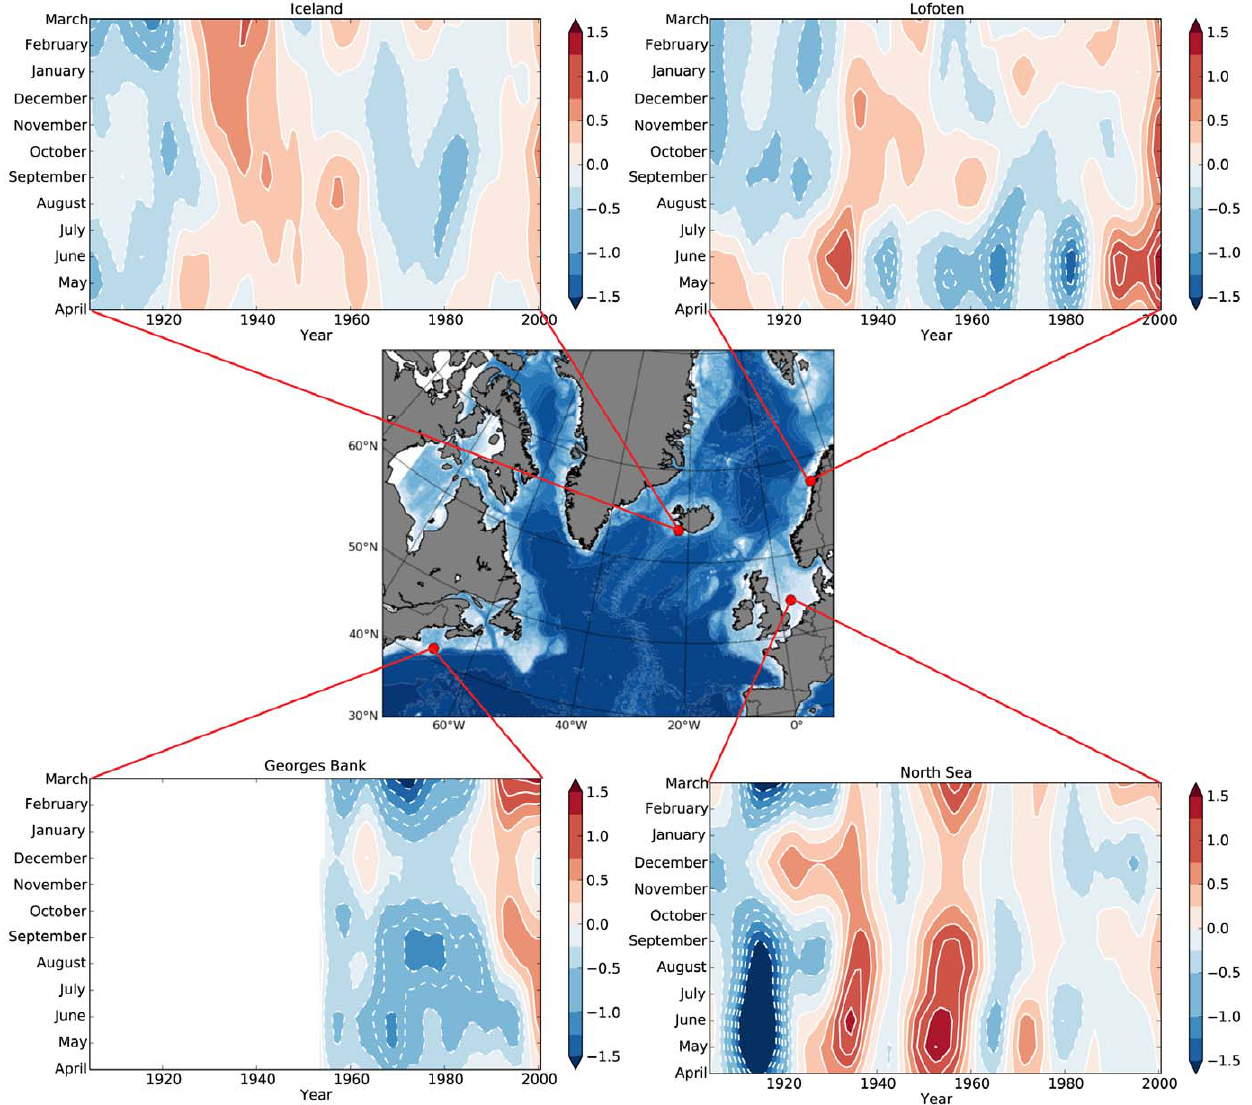
Figure 1. Map of four major spawning sites across the North Atlantic (middle) with time-series (1900–2006) of air surface temperature anomaly data for each site. Clockwise from top left Iceland, Lofoten, North Sea, and Georges Bank. The air temperature plots highlight the cold period during the 1960s and 1970s as well as the warm period during the 1930s and 1940s. Air surface temperature anomalies were calculated from a base climatology from 1961–1990, and smoothed using a 9-year running mean. The air temperature data [59] were provided by Nansen Centers in St. Petersburg (Russia) and Bergen (Norway) and are available from their web site at http://www.niersc.spb.ru/en/downloads/ nansensat/nansensat/.